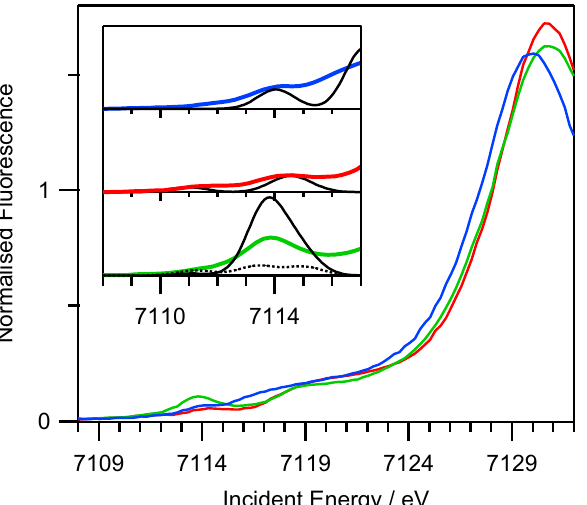
Figure 3. Fe K-edge XAS spectra of [Fe II (CN) 6 ] 4− (blue), [Fe III (CN) 6 ] 3− (red) and ox-ferri (green). Inset: Fe K-edge 1 s → 3 d pre-edge region, experimental data are plotted with thick lines. Simulated spectra from TD-DFT calculations plotted in thin black lines. For ox-ferri , simulated spectrum of the cis-[Fe III (CN) 4 (CH 3 CN) 2 ] 1− isomer with C 2v symmetry plotted with solid thin line and the trans-isomer with D 4h symmetry plotted with thin dashed